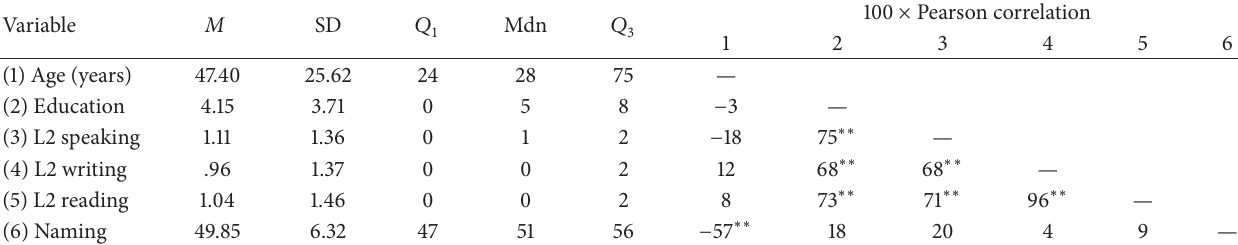
Table 2: Descriptive statistics for variables in the hierarchical multiple regression.